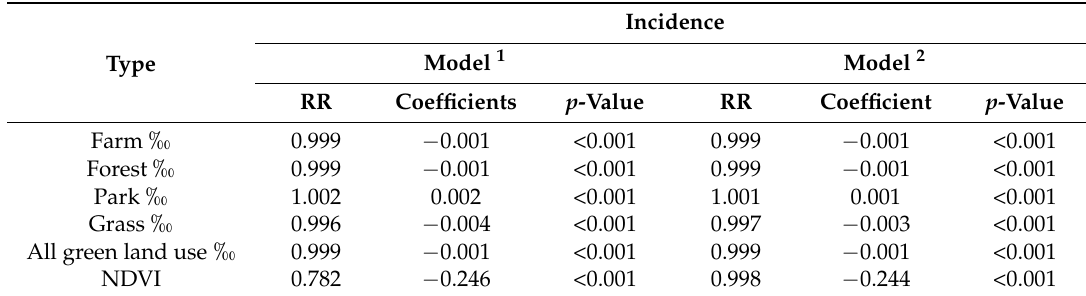
Table 2. Relative Ratios (RR) and Coefficients for Number of Dengue Cases and Different Types of Greenness in Generalized Linear Mixed Models.